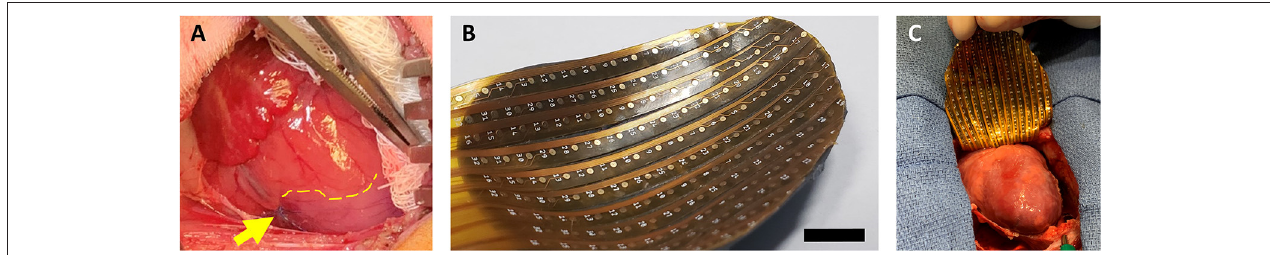
FIGURE 1 | Neonatal piglet myocardial infarction model and epicardial mapping. (A) Permanent ligation of the left anterior descending coronary artery (yellow arrow) was performed in piglets on postnatal day 1 or postnatal day 7 to induce myocardial infarction. The ischemic territory (below dotted yellow line) was visibly distinguished from the perfused myocardium by pallor and hypokinesis. (B,C) After 7 weeks, epicardial conduction mapping was performed using custom 3D-printed high-resolution mapping arrays with contoured shells matching the epicardial surface profile of the 7–8-week-old pig heart, ensuring optimal coverage and contact during mapping. Scale bar,